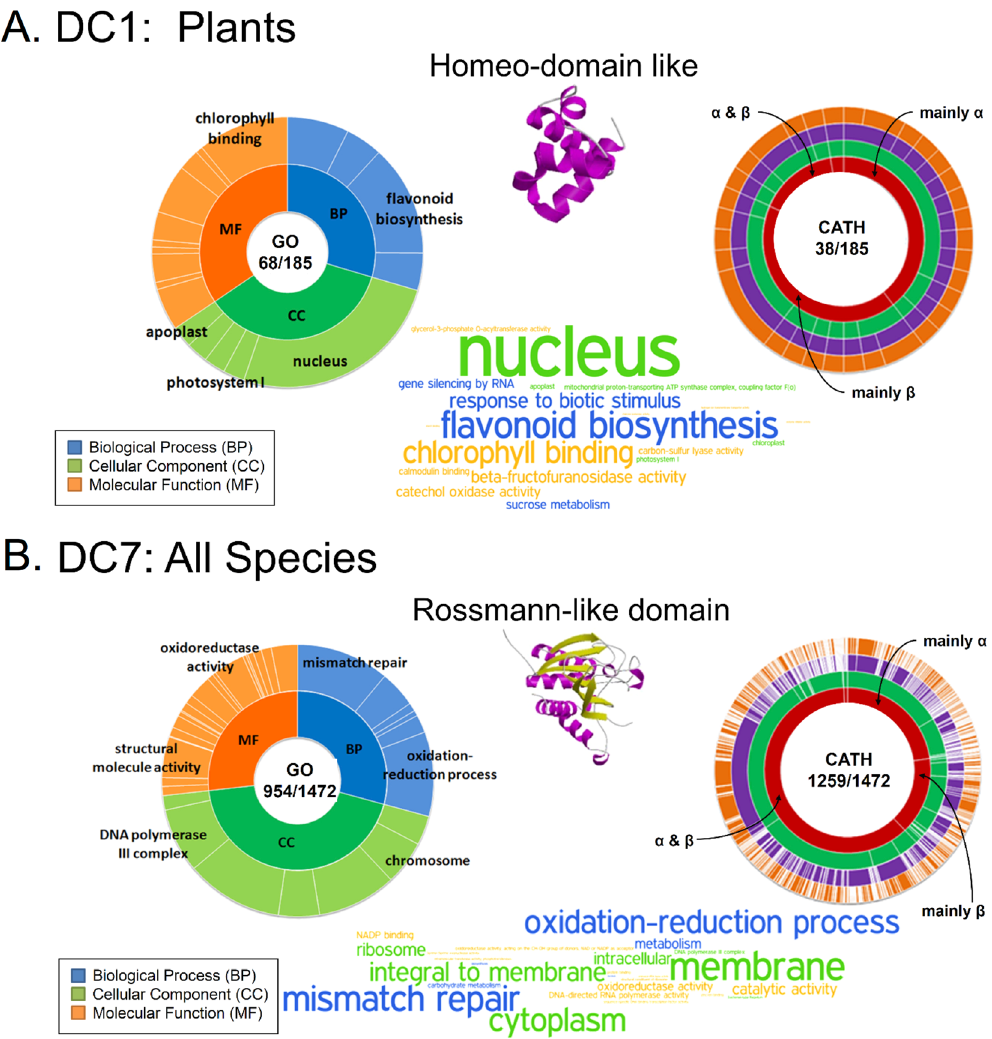
Figure 3. GO and CATH pies of the PD clusters DC1 and DC7. ( A ) DC1 (plants). ( B ) DC7 (all species). Left diagram: GO pie divided into 3 sections representing the 3 components of the GO annotation, biological process in blue, cellular component in green, and molecular function in orange. The outer circle displays the representative GO functions for the component, with white lines separating the different functions. Bottom center: the main representative GO functions are shown by GO TermLogo, with a bigger logo indicating a larger number of domains annotated with the logo function. Right diagram: CATH pie with four concentric circles, which represent, going from inside to outside, the 4 levels of the CATH classification, Class (red), Architecture (green), Topology (blue), and Homologous Superfamily (orange), with the categories (annotations) of each level separated by white lines. As in the GO pie, the number of PDs with an annotation was used to draw the divisions. The two numbers at the center of each GO and CATH pie are the number of PD with an annotation and the total number of PDs in the cluster. The 3D model shown between the two pies is an example of one of the PDs of the